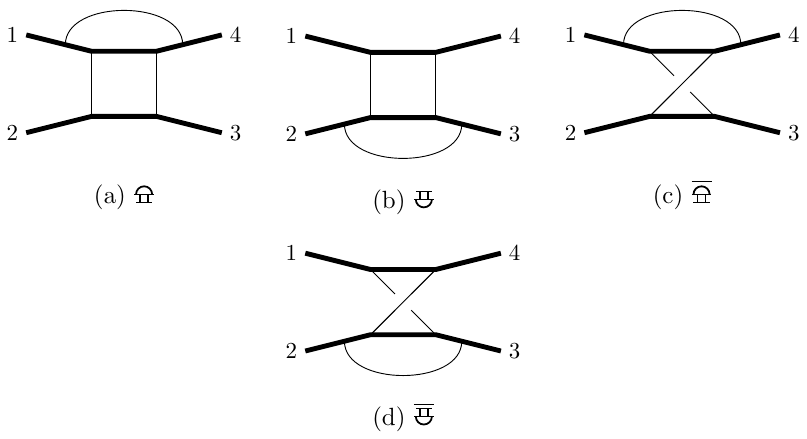
Figure 6. Two-loop integrals that include a